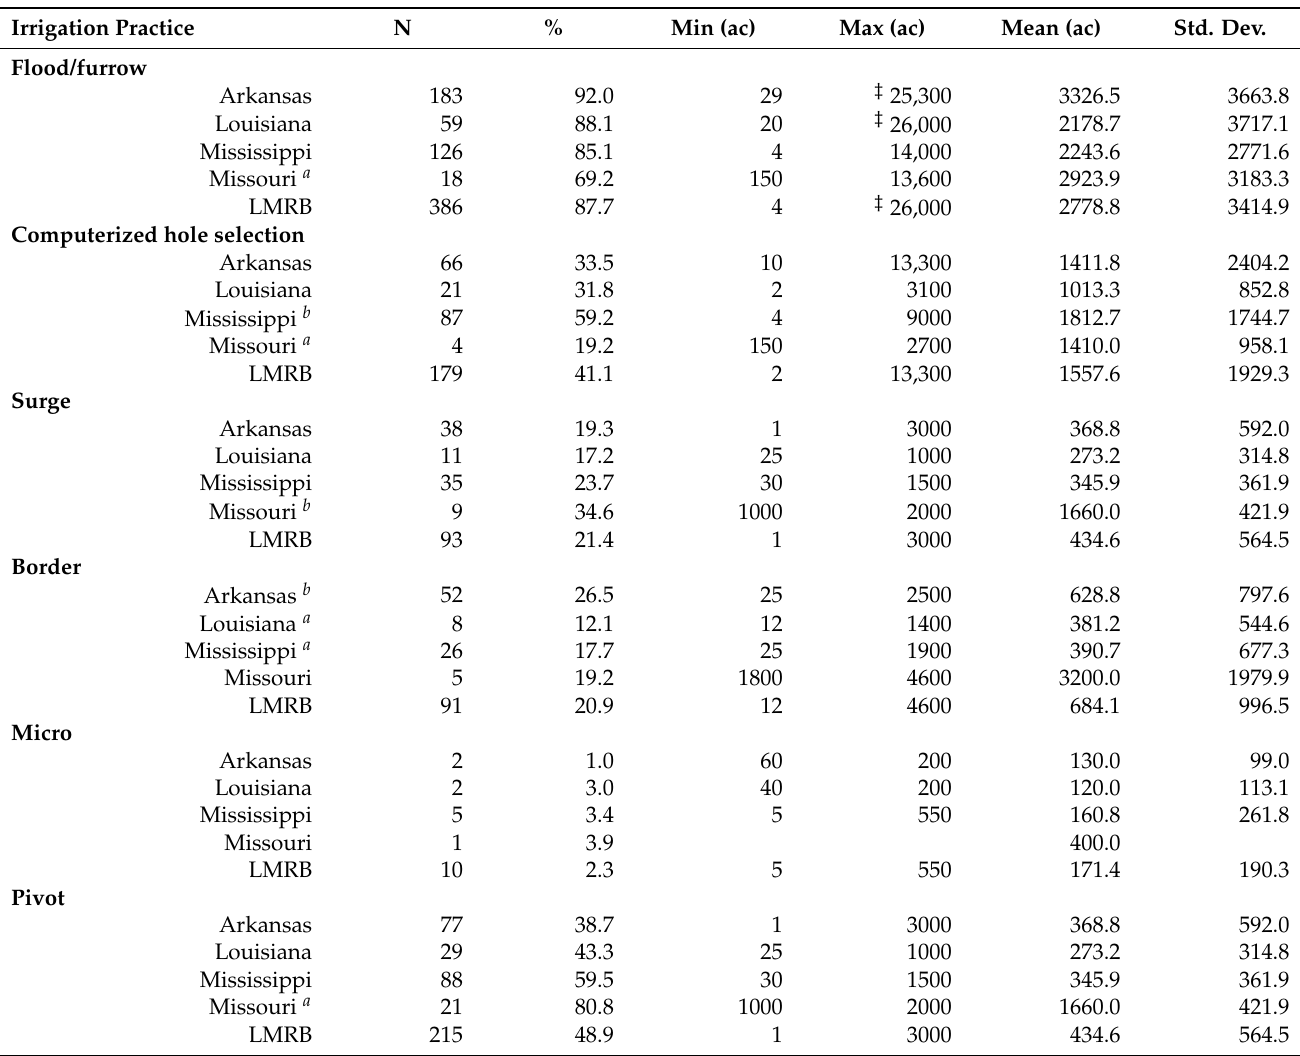
Table 6. Summary statistics of irrigation practices for row crops in the Lower Mississippi River Basin (LMRB) in